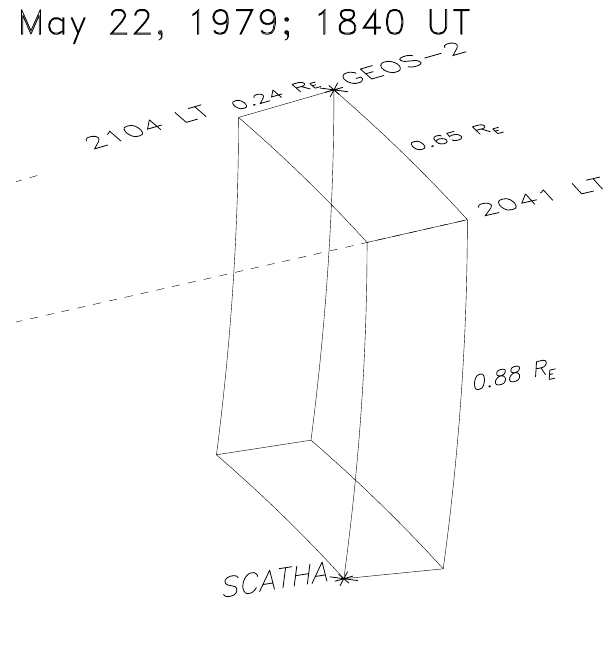
Fig. 2. Relative positions of GEOS-2 and SCATHA on 22 May 1979 at 18:40